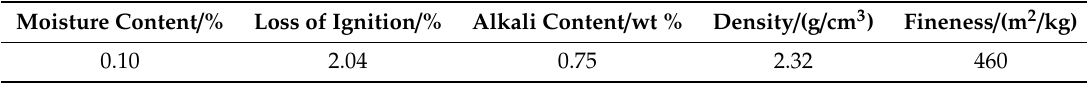
Table 3. Main physical properties of fly ash.